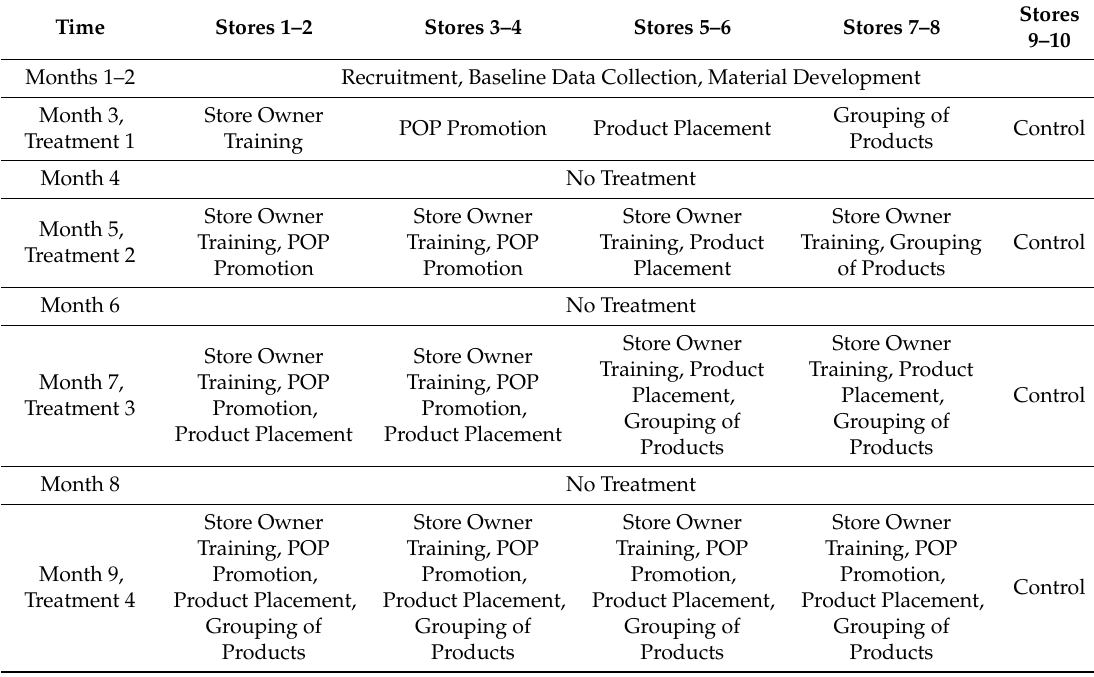
Table 1. B’more Healthy Corner Stores for Moms and Kids study design and